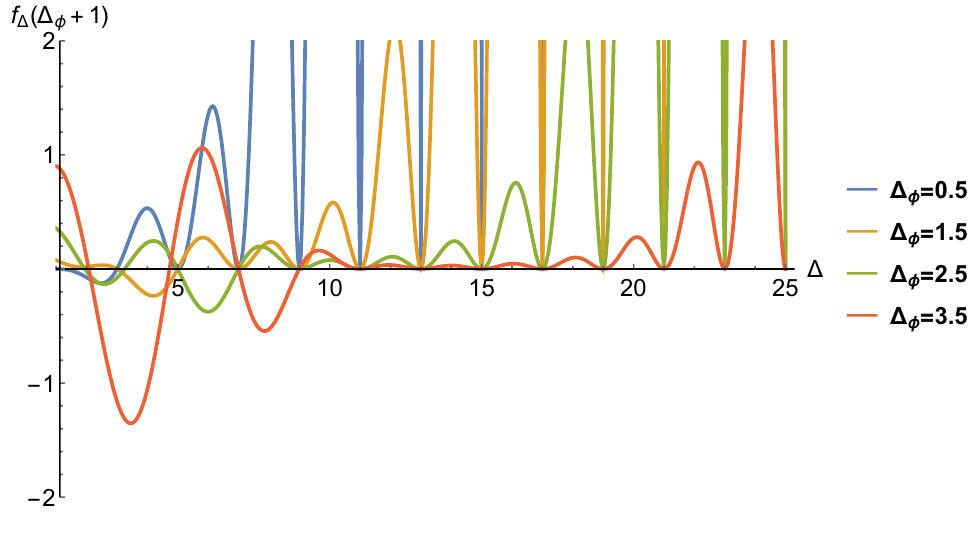
Figure 1. f (cid:1) ((cid:1) (cid:30) + 1) vs